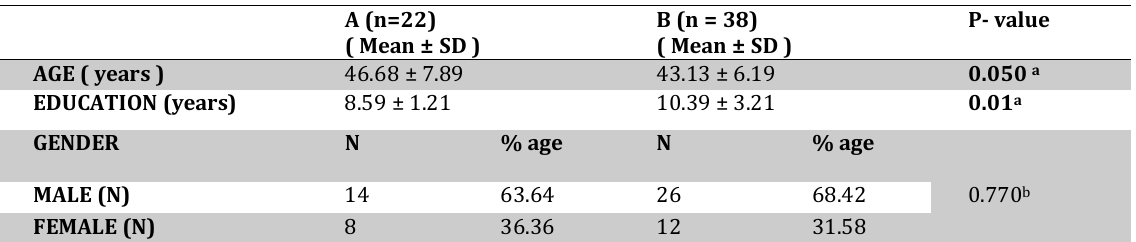
Table 1. Comparisons of Socio-demographic data of patients with and without psychiatric side-effects following Oseltamivir intake.